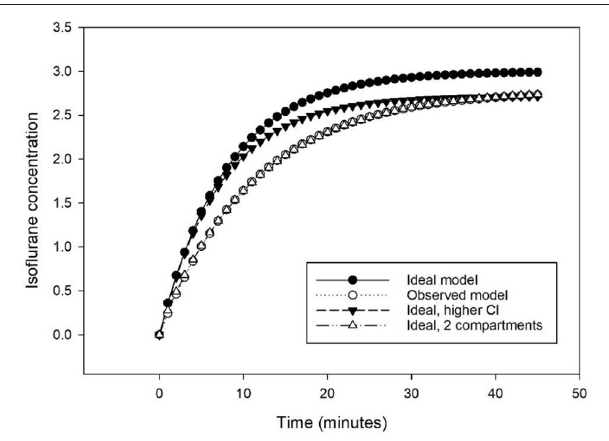
FIGURE 3 | Predicted isoflurane time course to increase from 0 to 3% at 5L min − 1 following a one-compartmental model of 40L and an elimination of 5L min − 1 (Ideal model), with an elimination of 5.52L min − 1 (Ideal, higher Cl), and with a 2-compartments model of 40L and an elimination of 5.52L min − 1 (Ideal, 2 compartments), compared to the observed time course (Observed model).